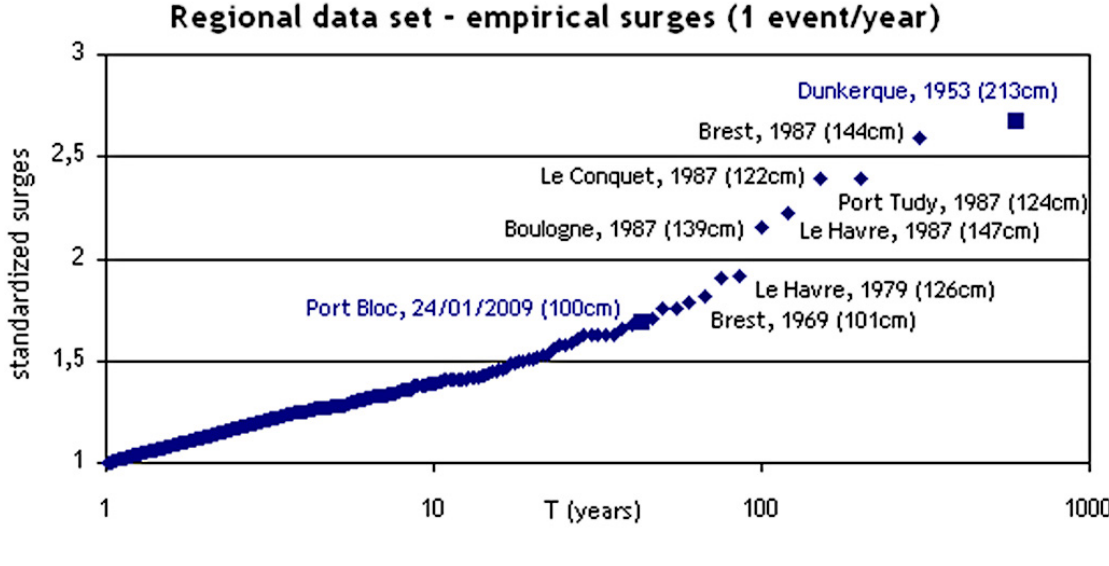
Fig. 7. Empirical distribution of the surges of the regional data set.